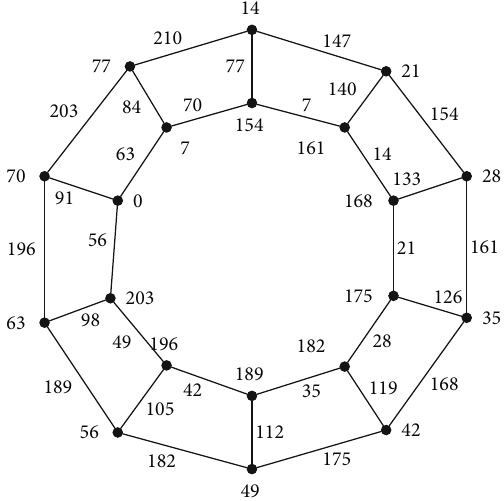
n with ordinary labeling.